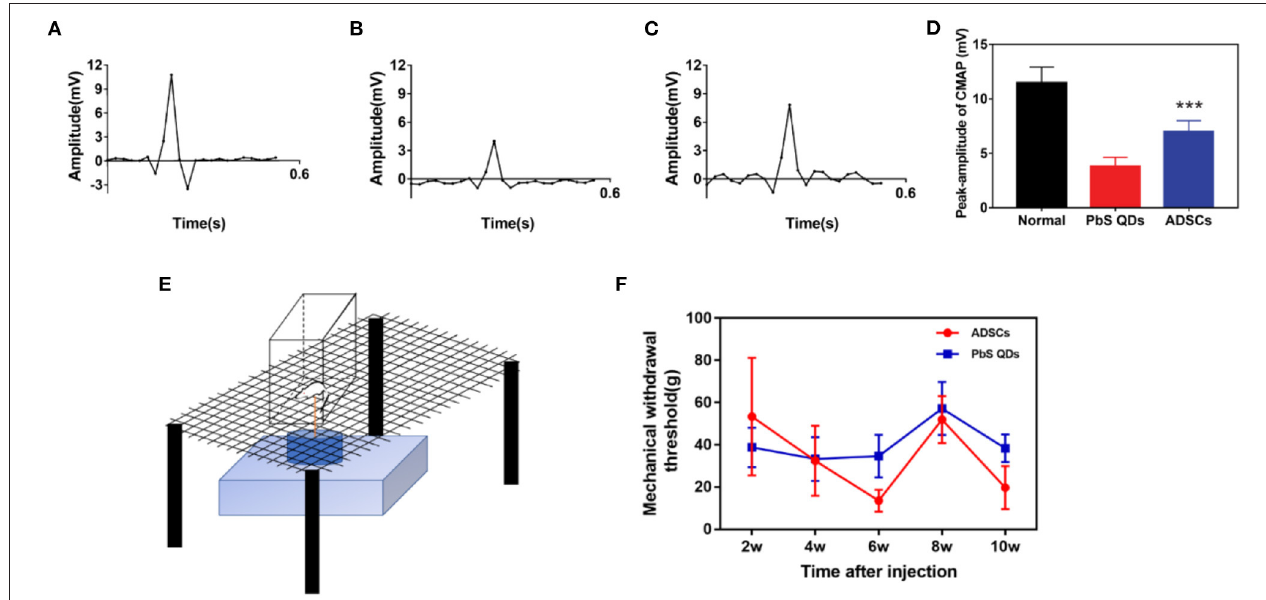
FIGURE 5 | Functional examination through electromyography and mechanical pain threshold. Electromyography of (A) healthy rats, (B) rats with PbS QDs injection, and (C) rats with PbS QDs labeled ADSCs injection at 3m post-injection. (D) Histogram of signal intensity measured from (A–C) . (E) Pattern diagram of Electronic Von Frey in rat. (F) Measurements of the mechanical withdrawal threshold of rat taken after injury (*** P < 0.001, vs. PbS QDs).